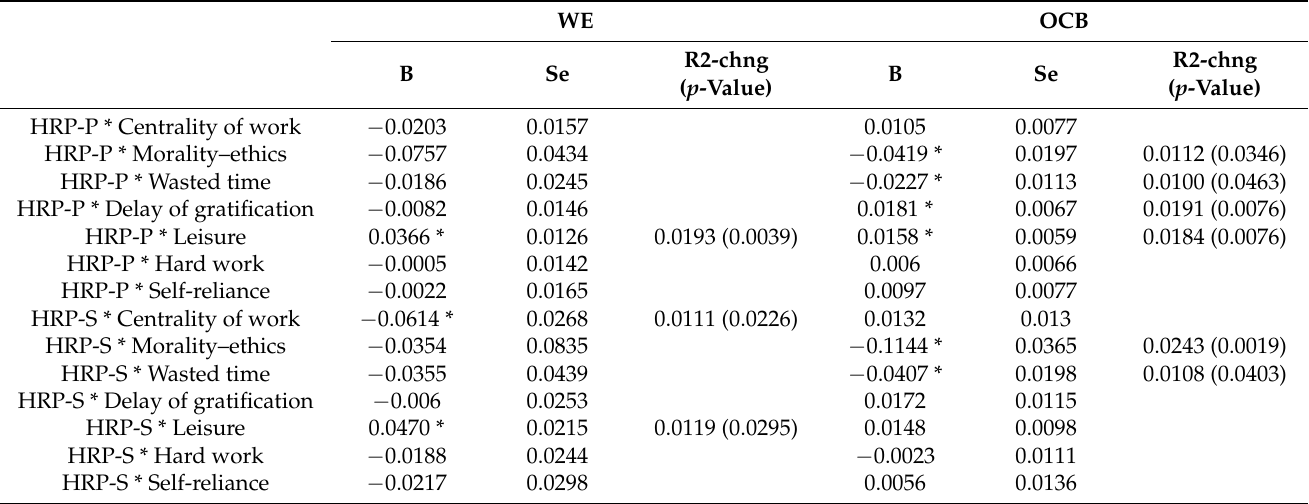
Table 2. Moderation of the PWE in the relationship of HRP-P, HRP-S with WE, and OCB. WE